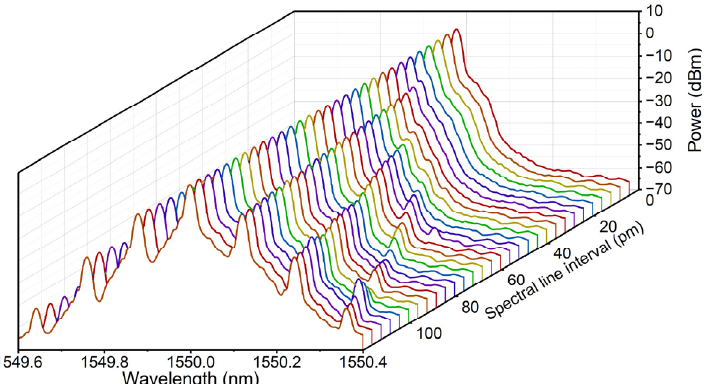
Figure 2. Measured electro-optic spectra when they are spaced with different intervals.